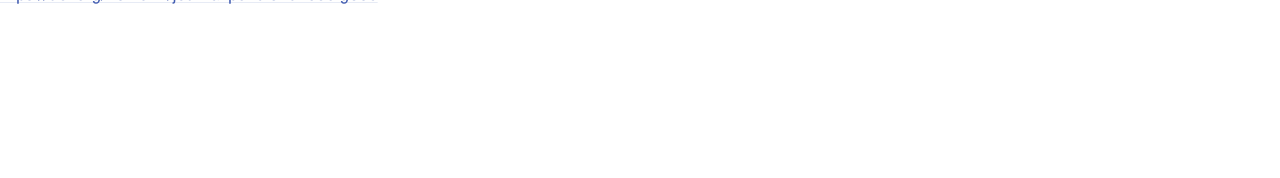
PLOS ONE | https://doi.org/10.1371/journal.pone.0251638 May 27,